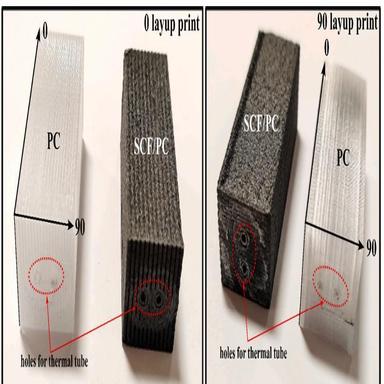
Thermal conductivity sample images printed in (a) 0◦ in XY plane (b) 90◦ in XY plane.